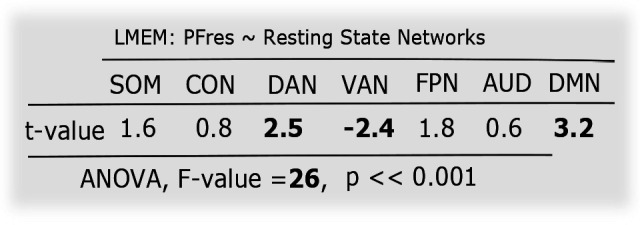
Distribution of the location independent PF (PFres) among resting state networks.T-values obtained from linear mixed effect modeling of the location independent PF among resting state networks. The network variable was defined as described in Figure 4. Here, we asked the question of whether the PF differs between resting state networks irrespective of its location? To answer this, we first regressed out from PF the changes that can be explained by linear dependencies on x,y,z, using LMEM, and again performed LMEM analysis (between PF and networks) as described for Figure 4. Interestingly, we found a significant difference among networks for PF. This was the case when looking at the standard resting-state networks and also when testing sensory against association areas. These results indicate that, beyond a global effect of location, networks still differ significantly in PF after removing the linear effects of location.